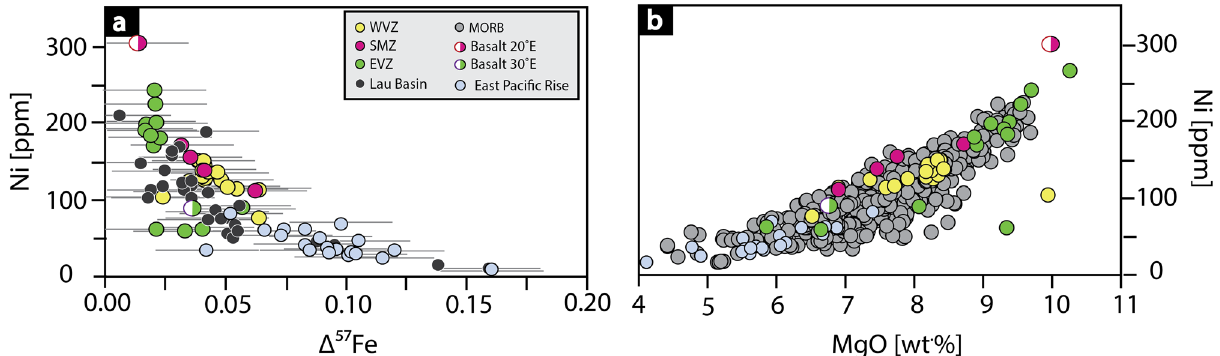
Figure 4. Crystal fractionation. Δ 57 Fe (a) and MgO (b) decreases exponentially with decreasing Ni content. This indicates that the modelling approach is valid, as both parameter (MgO and Δ 57 Fe) co-variate with Ni. Iron isotope data from the Lau Basin data are from Nebel et al. 40 and East Pacific Rise from Chen et al. 49 . MORB data shown in ( b ) are from Jenner and O’Neill 57 .